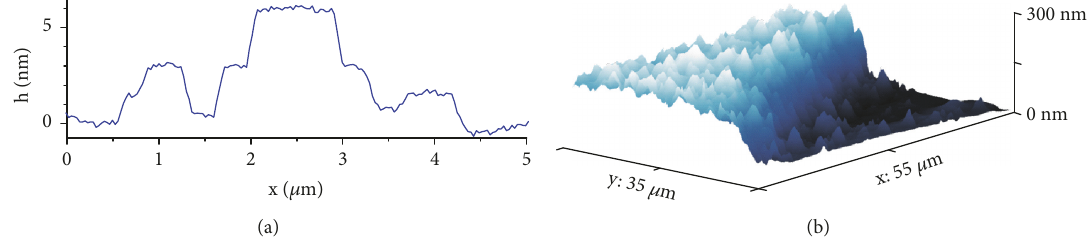
Figure 2: (a) Height profile of c-FLGS particles; (b) AFM image of the edge of c-FLGS